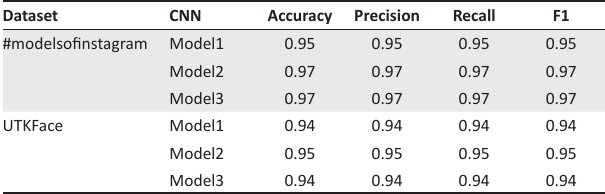
TABLE 3: The test evaluation metrics of each model and